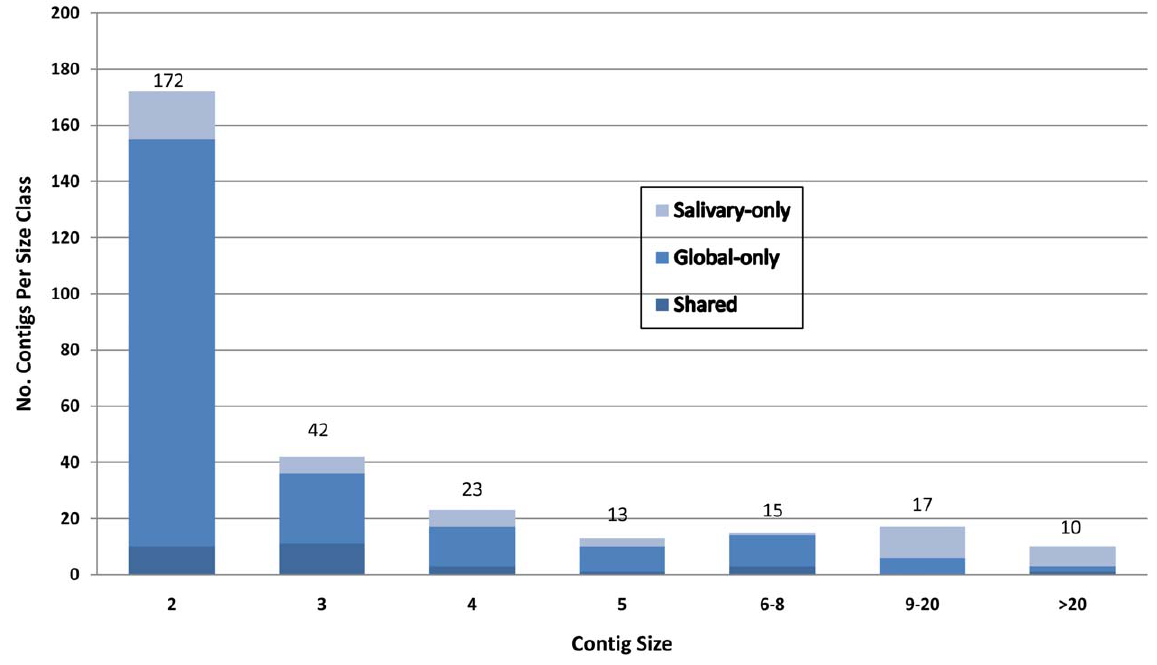
Figure 1. Histogram of 1,035 An.funestus EST contigs (clusters of $ 2 sequences) resulting from a combined assembly of ESTs from two sources. Sources were the whole body transcriptome of mixed developmental stages and sexes, and the adult female salivary glands. Numbers above the bars represent the total number of contigs per contig size class. Not shown are the 744 singletons containing only one EST.